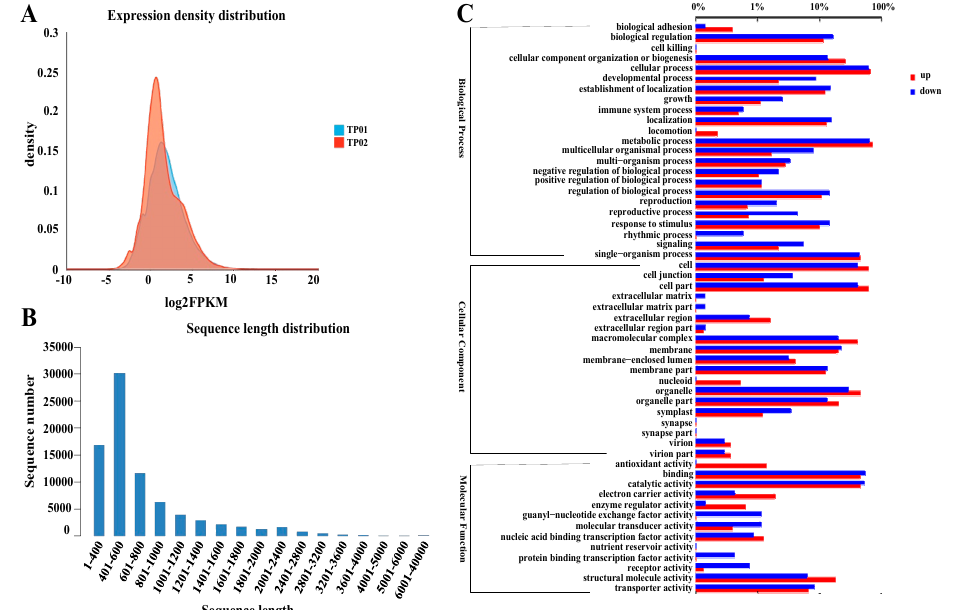
Figure 3. Global transcriptome analysis. ( A ) The density distribution map of gene expression. ( B ) The sequence length distribution of unigenes in P. acinosa under 0 and 3.0 mmol/L K + treatment. ( C ) Classification of the genes in response to the K + starvation treatment compared with the 3.0 mmol/L K + treatment via Gene Ontology (GO) analysis.